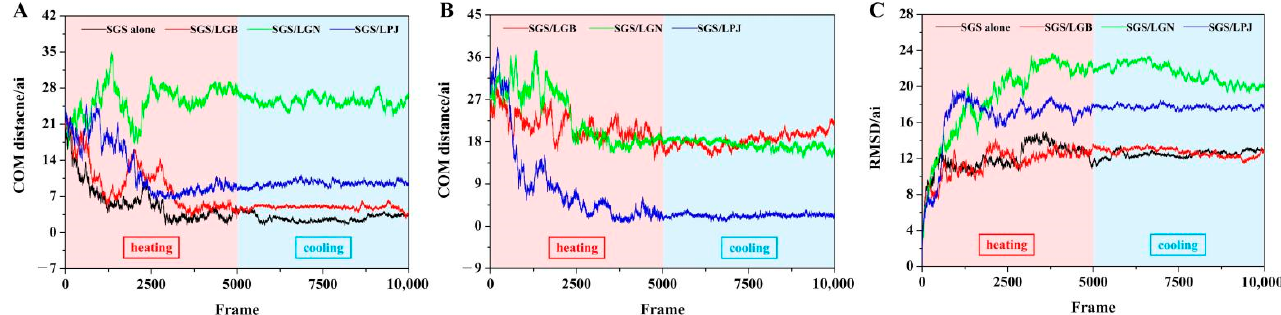
Figure 6. ( A ) COM distance between two SGS chains, ( B ) COM distance between two SGS chains and phenolic compounds of LRE, ( C ) RMSD value of different interaction system. (Total simulation time: 2 × 10 − 8 s, total frames: 10,000. “ai”: the unit of length. 1 ai = 1 × 10 − 10 m. Heating process: 0 to 4999 frames, temperature was set at 370 K. Cooling process: 5000 to 10,000 frames, temperature was set at 277 K.) LRE: Ligustrum robustum (Rxob.) Blume extract.